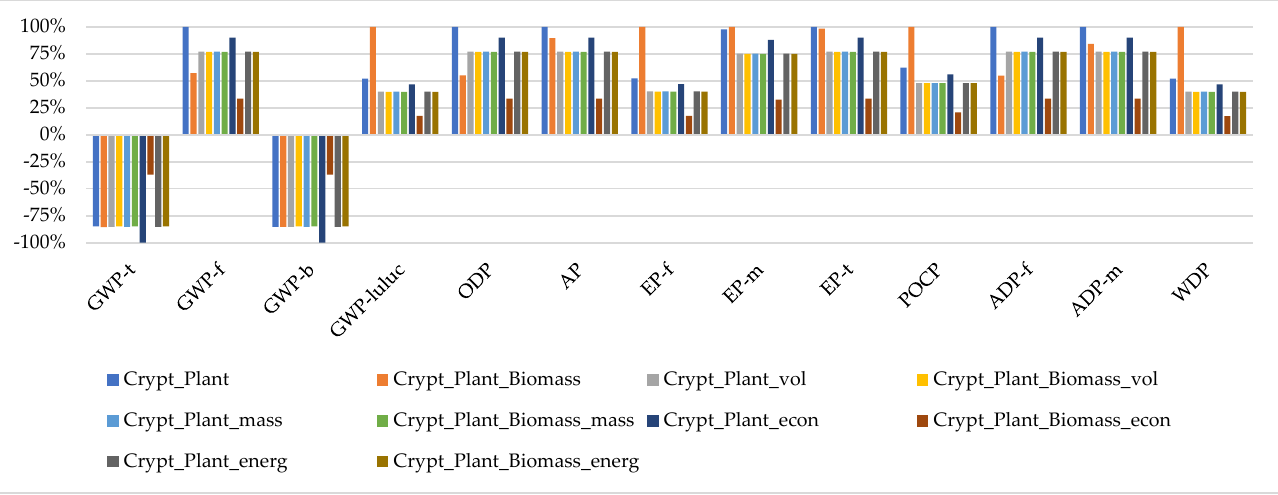
Figure 4. Relative environmental impacts of biomass and roundwood from Euc_Plant scenario.